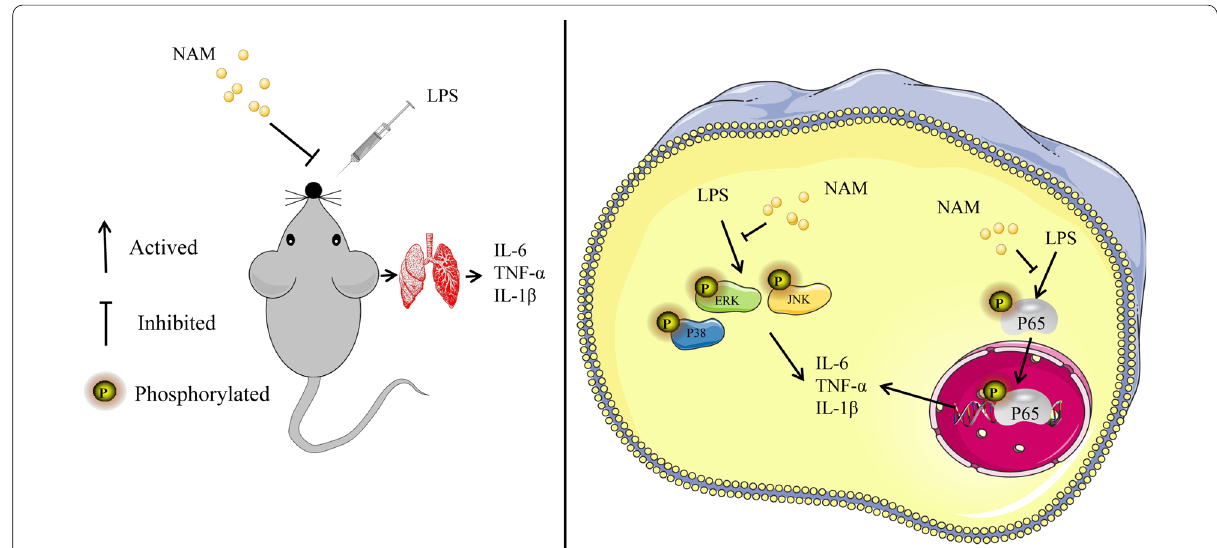
Fig. 9 Mechanism of NAM alleviating LPS induced lung